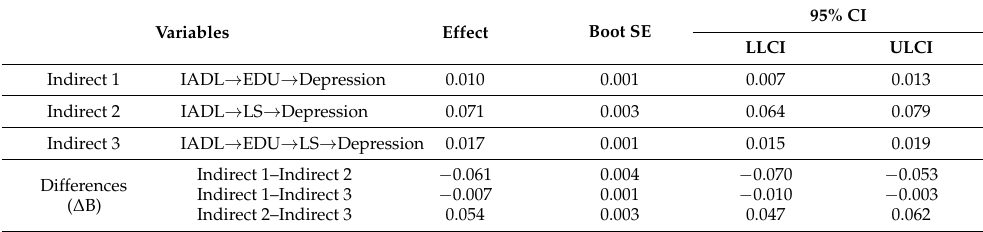
Table 5. Validation of mediating effect (bootstrapping) ( n = 9906). Variables Effect Boot